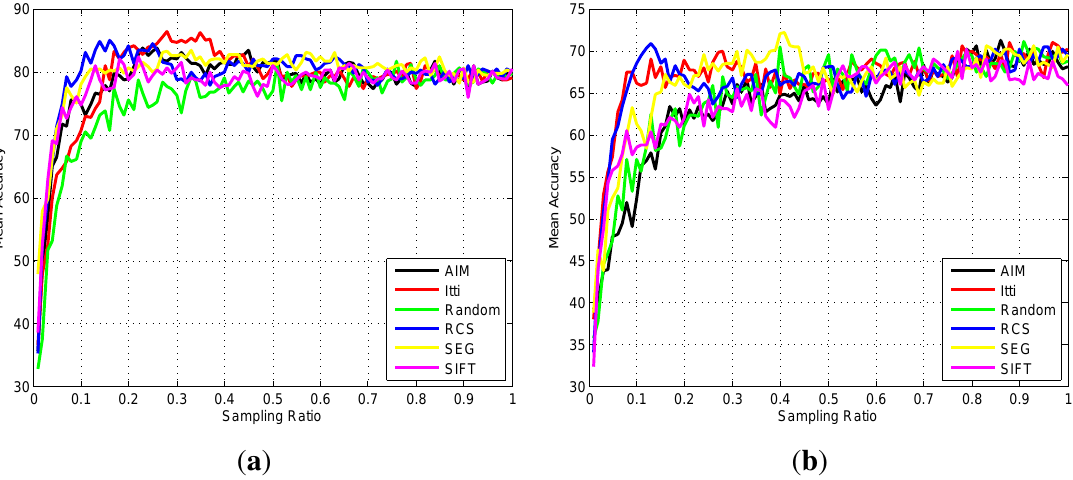
Figure 15. Comparisons of the classification accuracy using different sampling methods on airplane ( a ) and storage tanks ( b